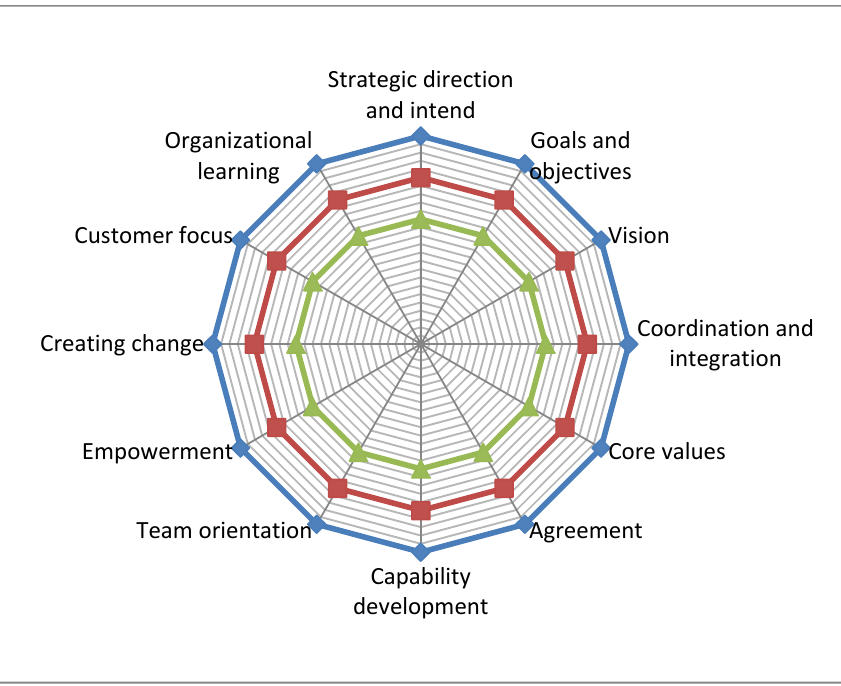
Fig. 1. The structure of Denison